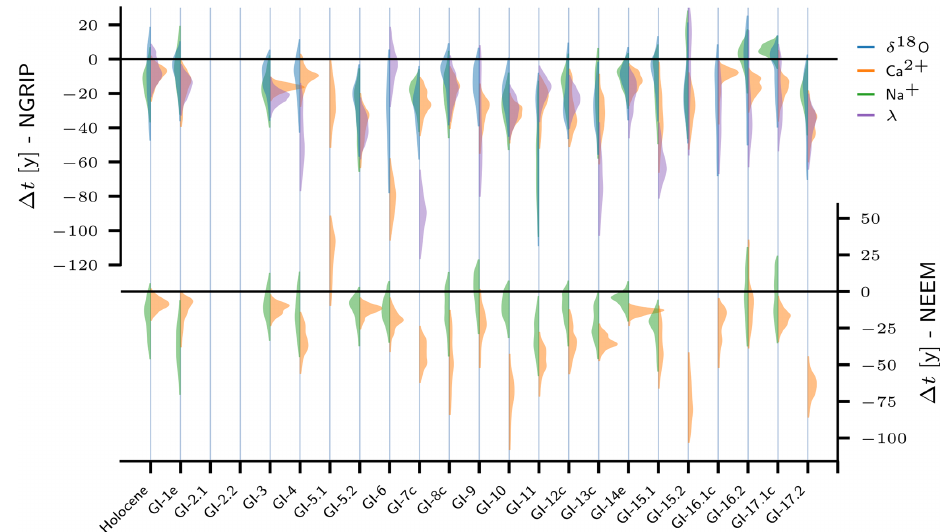
Figure 2. DO events (Greenland interstadial onsets) for which Erhardt et al. (2019) provide high-resolution proxy data (Ca 2 + , Na + , and λ ) for windows centered around the transitions. δ 18 O data for the corresponding windows were retrieved from continuous δ 18 O time series measured in 5cm steps in the NGRIP ice core (see Fig. 1). The posterior probability densities for the transition onsets with respect to the timing of the DO events according to Rasmussen et al. (2014) are shown in arbitrary units for all proxies. They were recalculated using the data and the method provided by Erhardt et al. (2019). The uncertain transition onsets are only shown for those transitions investigated in this study – the selection is adopted from Erhardt et al. (2019) to guarantee comparability.